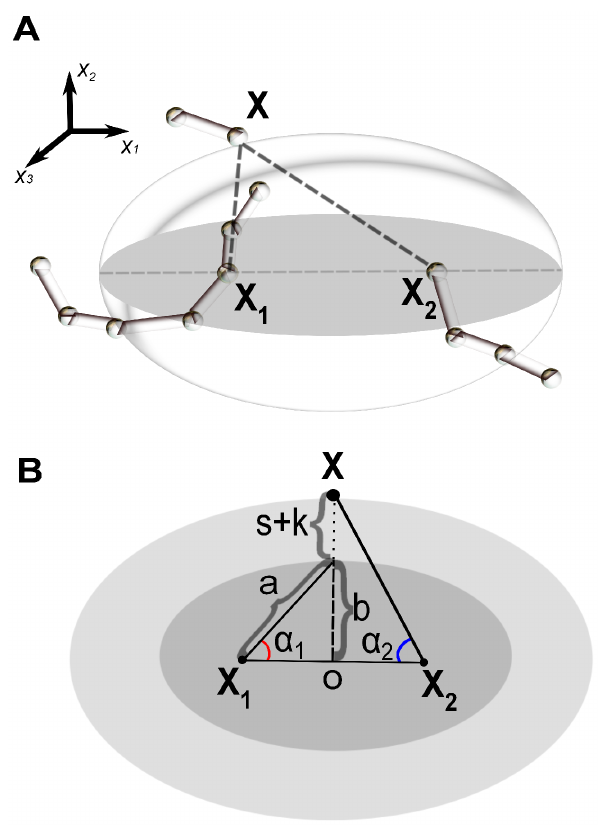
Figure 5. Schematic illustration of ellipsoid criterion. (A) Three dimensional view of a point x locating on the ellipsoid constructed from the total loop length L and the two foci x 1 and x 2 . (B) Two dimensional view along through the x 3 -axis of the ellipsoid, with DD x 1 { x 2 DD a ~ L = 2 and b ~ c ~ ½ ( L = 2) 2 { ( ) 2 (cid:3) 1 = 2 (dark gray). c is along x 3 - 2 axis, not shown. The maximum side-chain length is denoted as s and the distance cut-off of interaction is k . The enlarged ellipsoid, which has updated a and b , is also shown (light gray).